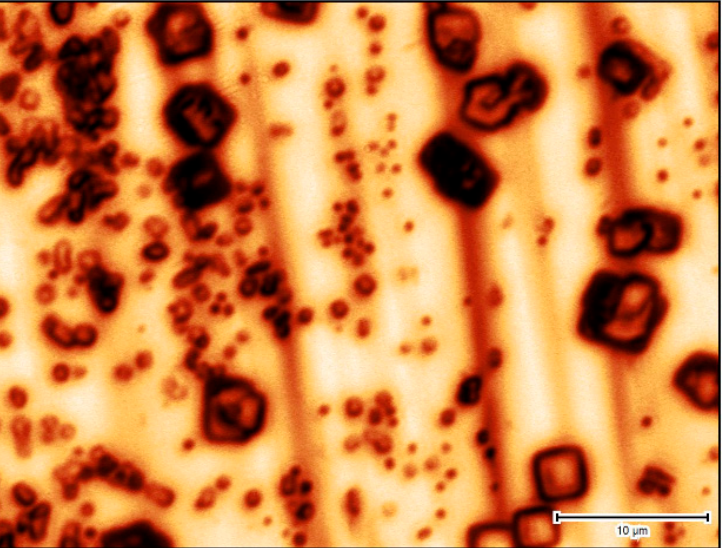
Figure 13. Halite cubes on the (010) surface of gypsum. The halite crystals precipitated from a solution originally undersaturated ( Ω halite ~ 0.1) with respect to the mineral.